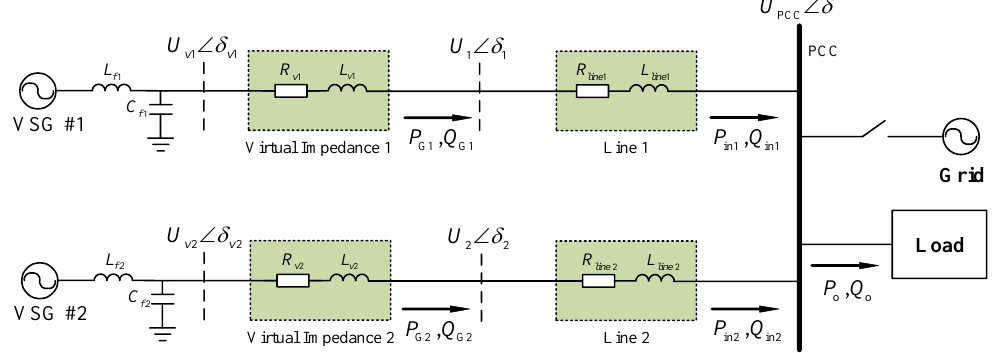
Figure 9. Test example of the multiple parallel VSGs system (two-parallel VSGs).